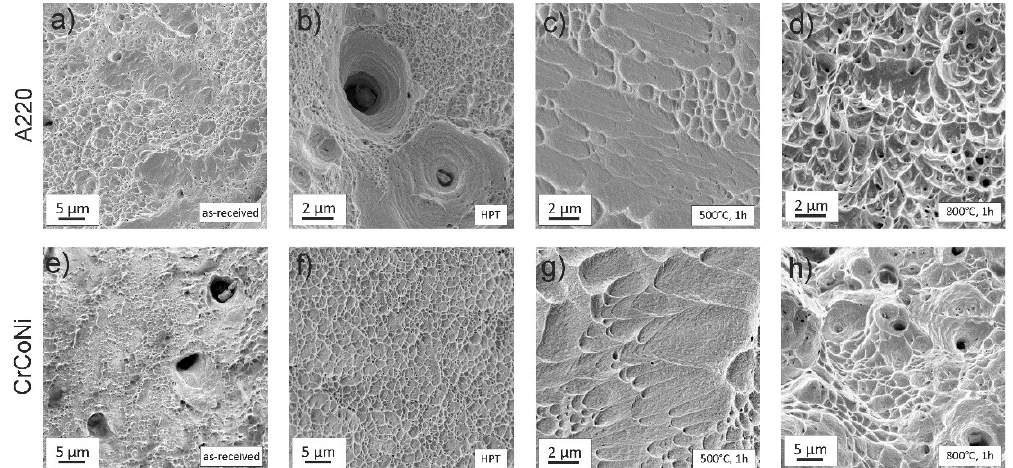
Figure 11. Fracture images of tensile tested samples, ( a – d ) of the A220 alloy. The as-received, ( a ), and the HPT state, ( b ), show highly ductile fracture features. After annealing at 500 °C, 1 h some dimples can still be found, however overall plasticity is quite limited. Despite the formation of σ-phase during 800 °C, 1 h annealing the fracture still occurs in a ductile fashion, with voids and dimples usually forming around this second phase. ( e – h ) Fractured samples of CrCoNi. The as-received state shows a highly ductile fracture surface, see ( e ). ( f ) HPT state: Due to the high purity of the sample the overall fracture surface contains fewer voids, but it is overall still dominated by dimple formation characteristic for a ductile fracture. The fracture mode remains a ductile one, even during annealing at 500 °C, 1 h, ( g ) and 800 °C, 1 h, ( h ).